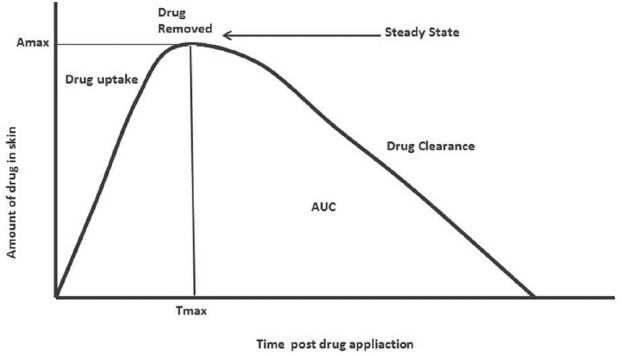
FIGURE 2 - Schematic diagram illustrating the DPK drug analysis in the stratum corneum by tape stripping methodology recommended in FDA guidance